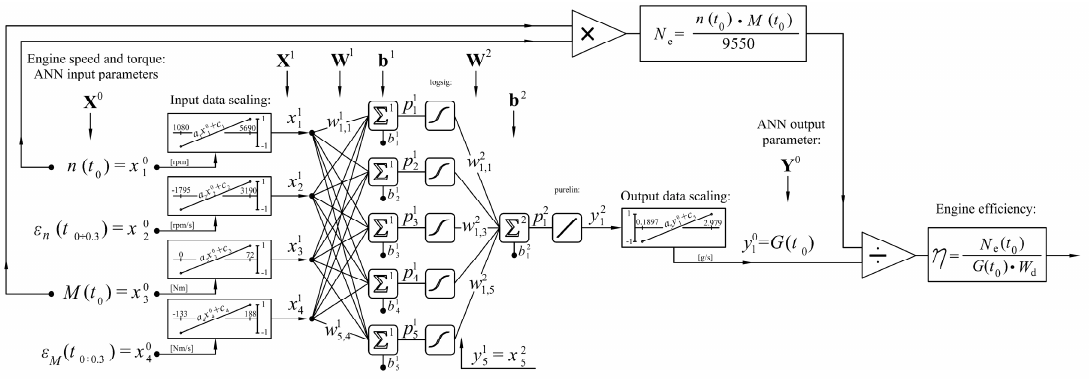
Figure 6. ANN used for computing engine efficiency in dynamic states. 190